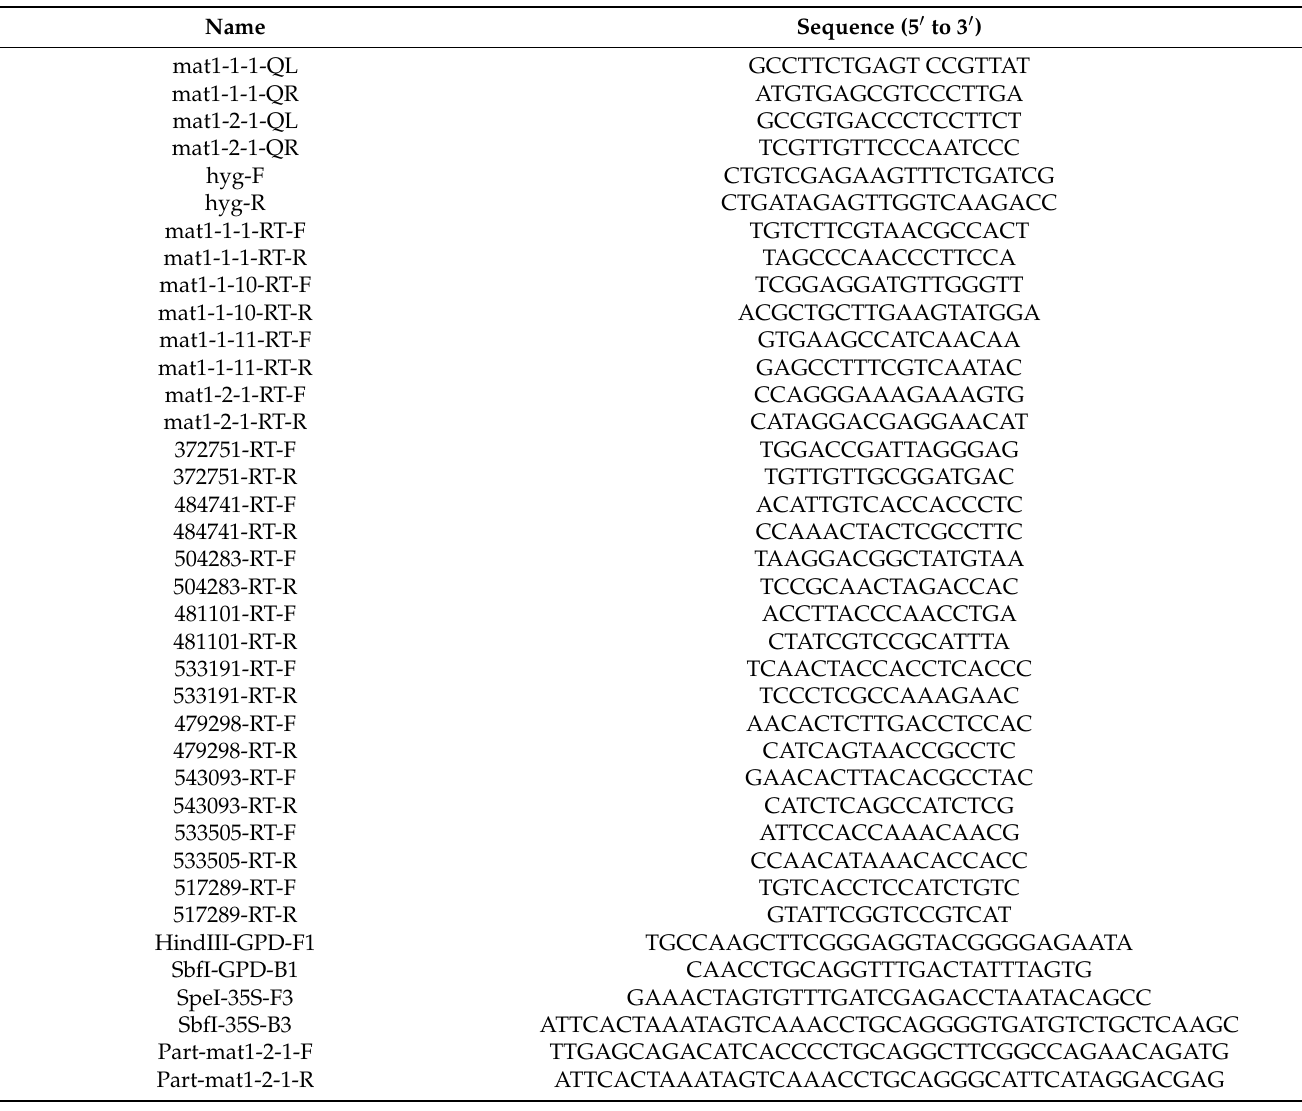
Table 1. Primers used in this